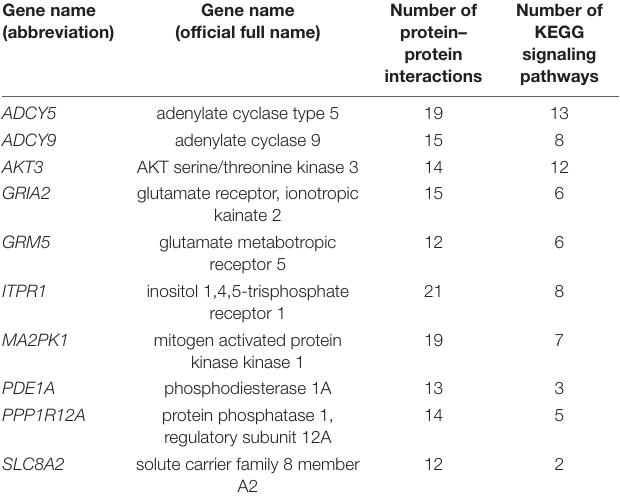
TABLE 5 | Summary of 10 key